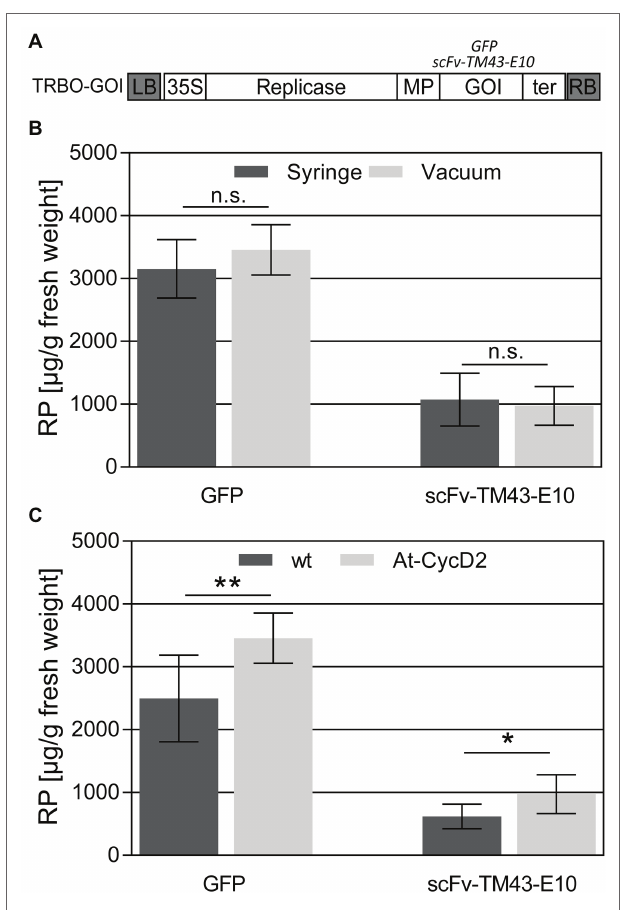
FIGURE 5 | Accumulation of recombinant proteins in leaves of N. benthamiana . (A) Schematic representation of the TRBO expression vector. Open boxes indicate the following genes: Rep, viral replicase; MP, movement protein; GOI, gene of interest; 35S, 35S promoter. LB, RB, left and right border of T-DNA, respectively. Wild type (wt) and At-CycD2 transgenic plants were agroinfiltrated with the TRBO- gfp and TRBO- scFv-TM43-E10 . (B) Comparison of the agroinfiltration methods (vacuum and syringe) in the At-CycD2-15 transgenic plants. (C) Comparison of the GFP and scFv- TM43-E10 accumulation in vacuum infiltrated wild type (wt) and At-CycD2-15 transgenic plants. Recombinant protein concentration is expressed in μ g/g leaf fresh weight. Y-axis, RP is a recombinant protein. Values represent the means with standard deviation ( n = 7). Asterisks indicate significance as determined by the Mann–Whitney test, with * and ** denoting p < 0.05 and p < 0.01, respectively. Not significant values are determined as